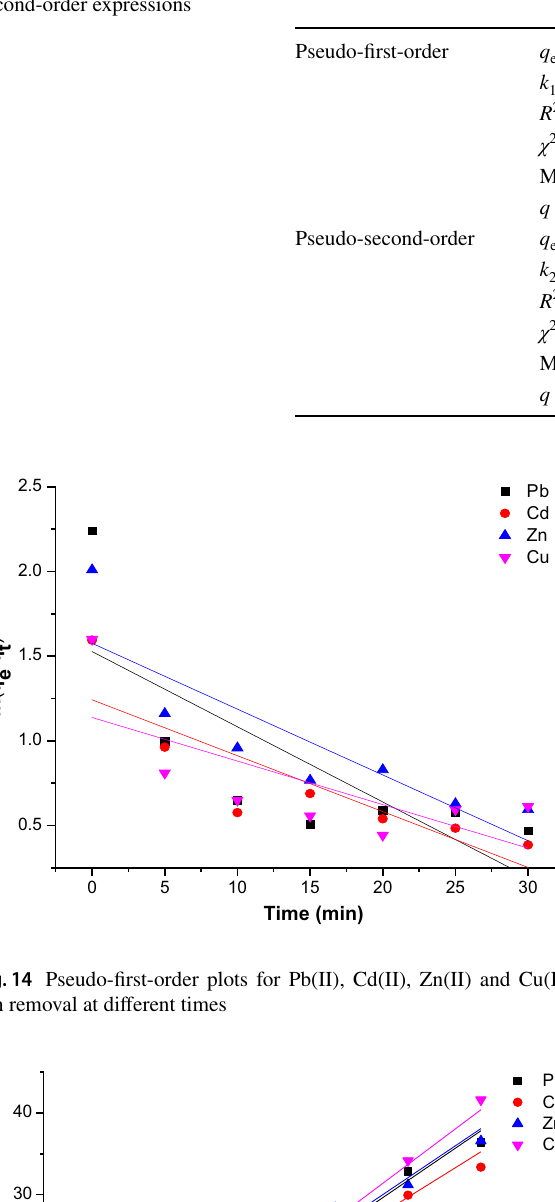
Table 4 Kinetic parameters of pseudo-first-order and pseudo- second-order expressions